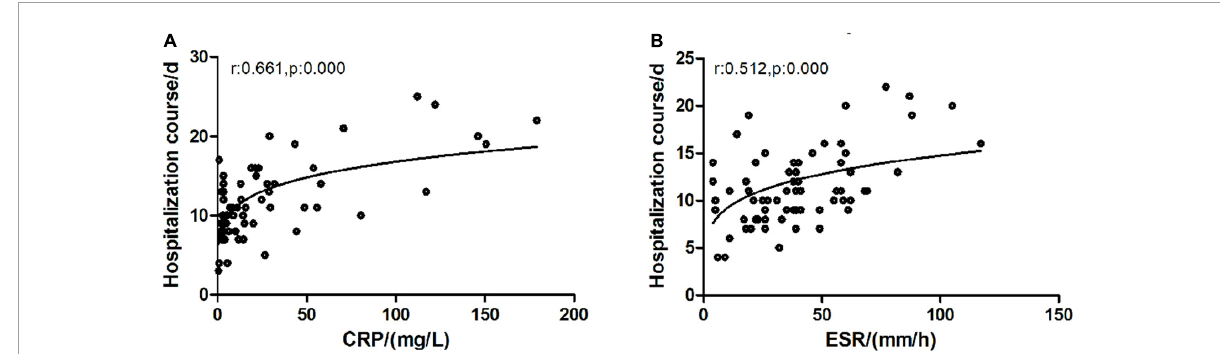
FIGURE5 Correlation of CRP/ESR with hospitalization course. CRP, C-reactive protein; ESR, erythrocyte sedimentation rate. (A) C-reactive protein and hospitalization course exhibited a significantly positive correlation (Spearman test, r = 0.683, p = 0.000). (B) ESR and clinical course exhibited a significantly positive correlation (Spearman test, r = 0.512, p =